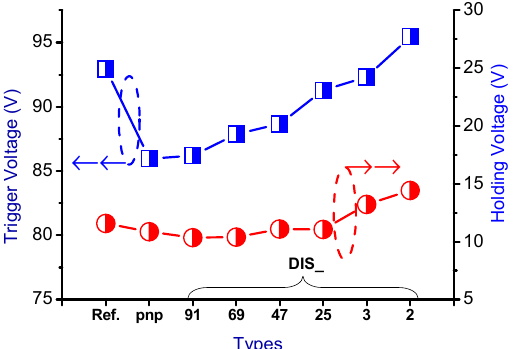
Figure 9. V t1 and V h diagrams of the nLDMOS-SCR ( p-n-p -arranged) tested samples.